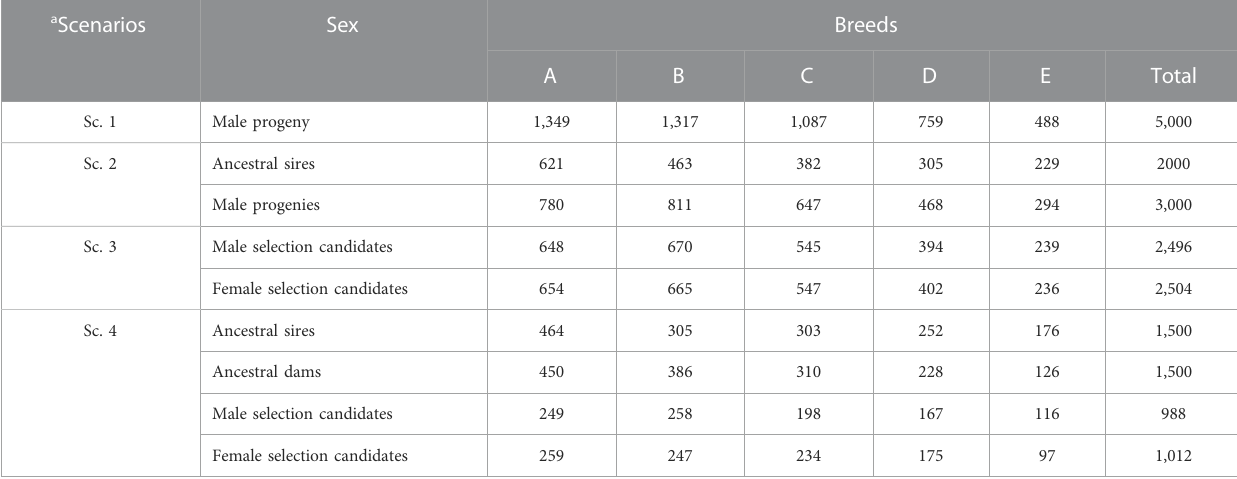
a Sc.1:5,000randomlyselectedmaleprogeniesfrom15thgenerationweregenotyped,Sc.2:2000ancestralsireswithmorethan10progeniesand3,000randomlyselectedmaleprogeniesfrom 15thgenerationweregenotyped,Sc.3:5,000selectioncandidates(bothmalesandfemales)from15thgenerationweregenotyped,SC4:randomlyselected1,500ancestralsires,1,500ancestral dams and 2000 selection candidates (both males and females) from 15th generation were